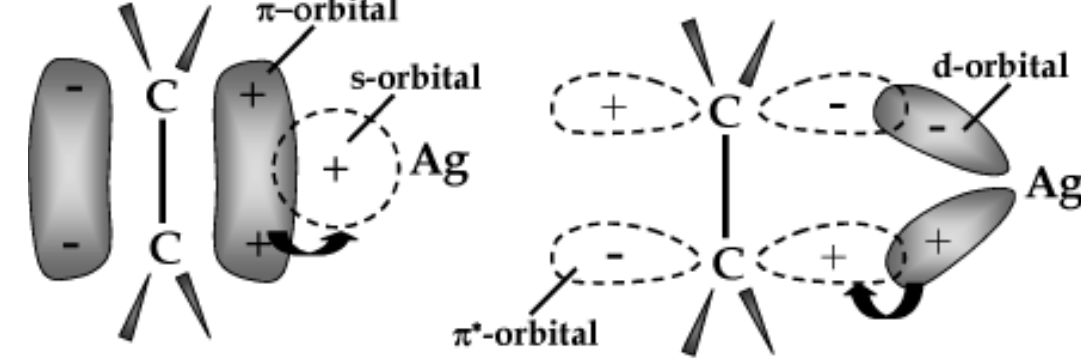
Figure 2. Scheme of the complexation of silver ions and olefins (from ref.